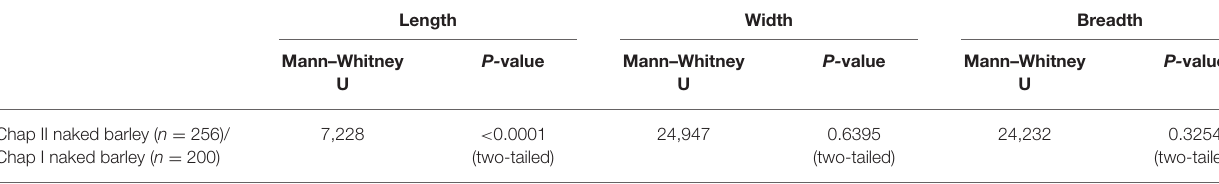
TABLE 1 | Chap II vs. Chap I naked barley. Length Width